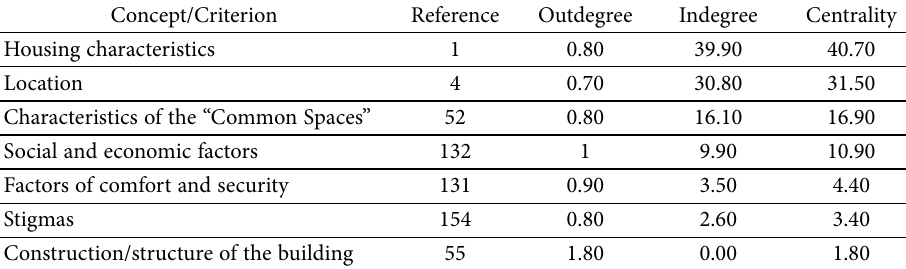
Table 1. Criteria with highest degrees of intensity (based on